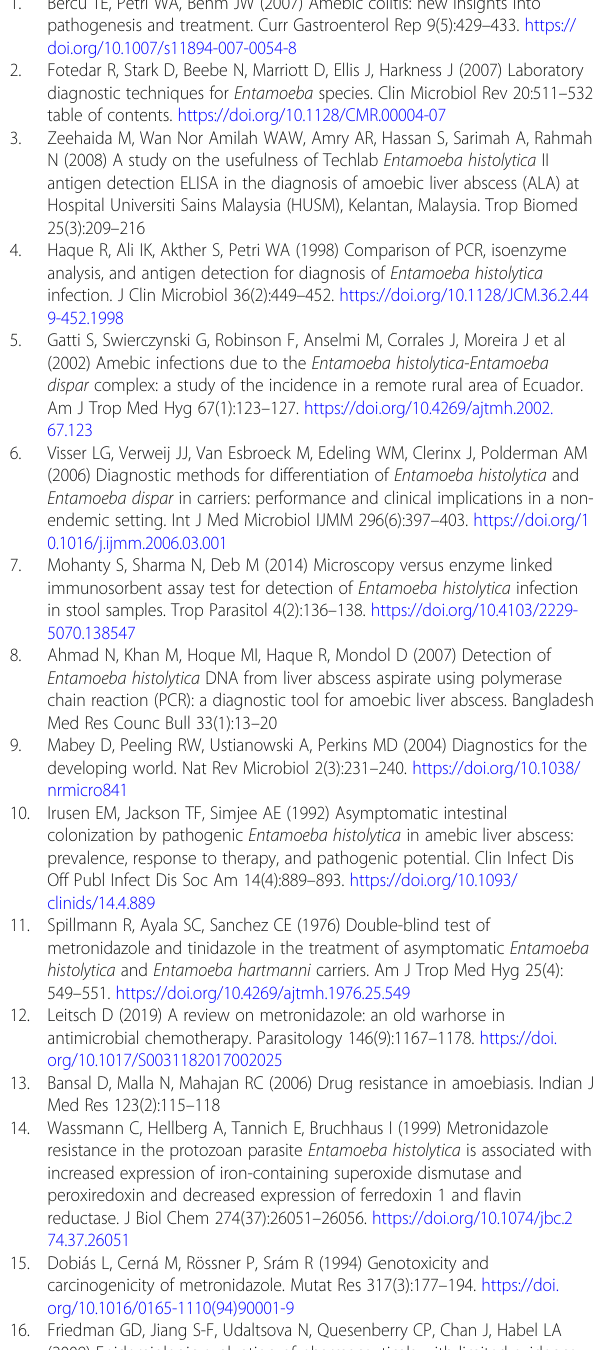
table of contents. https://doi.org/10.1128/CMR.00004-07